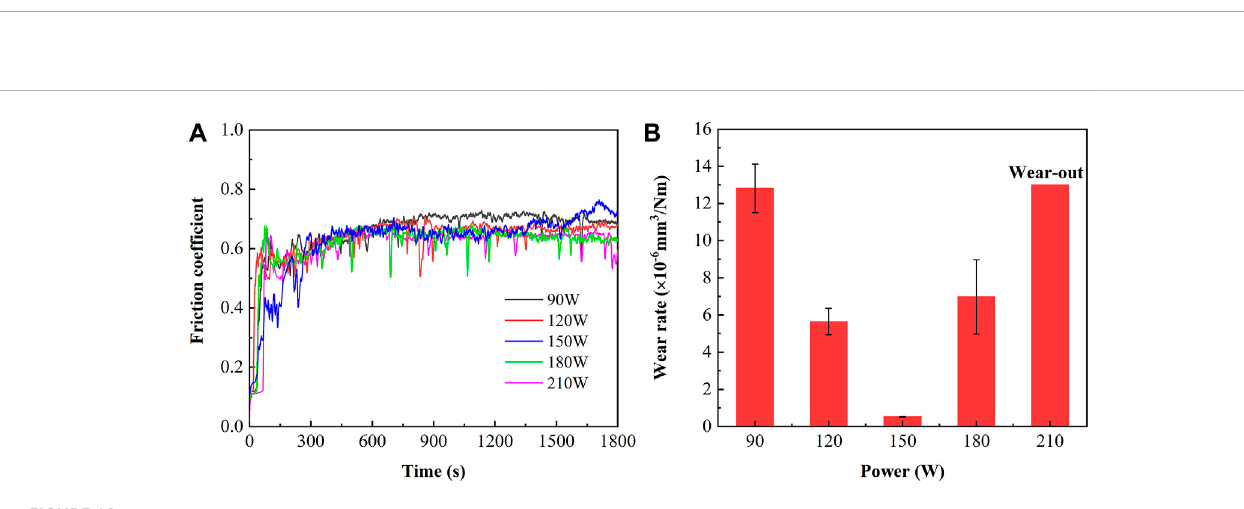
FIGURE 10 (A) Friction coef fi cient curve and (B) wear rate of the ZrNbTiMo RHEA fi lms deposited at different sputtering